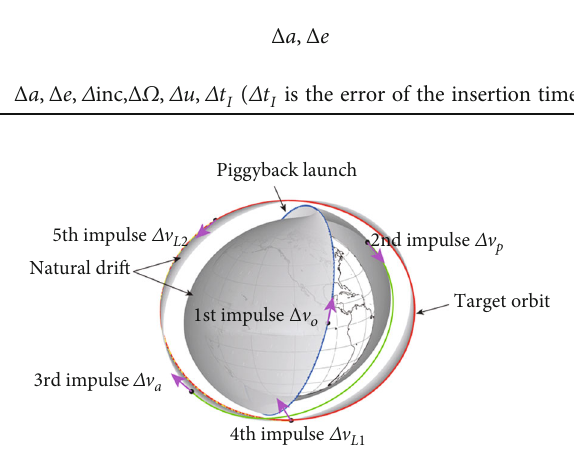
Figure 18: Transfer process of satellite